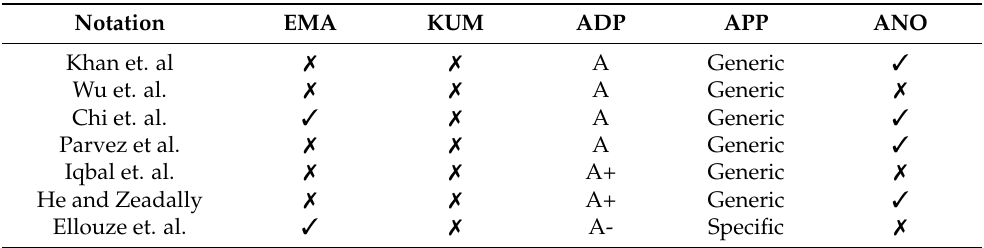
Table 4. Comparison by functionality.